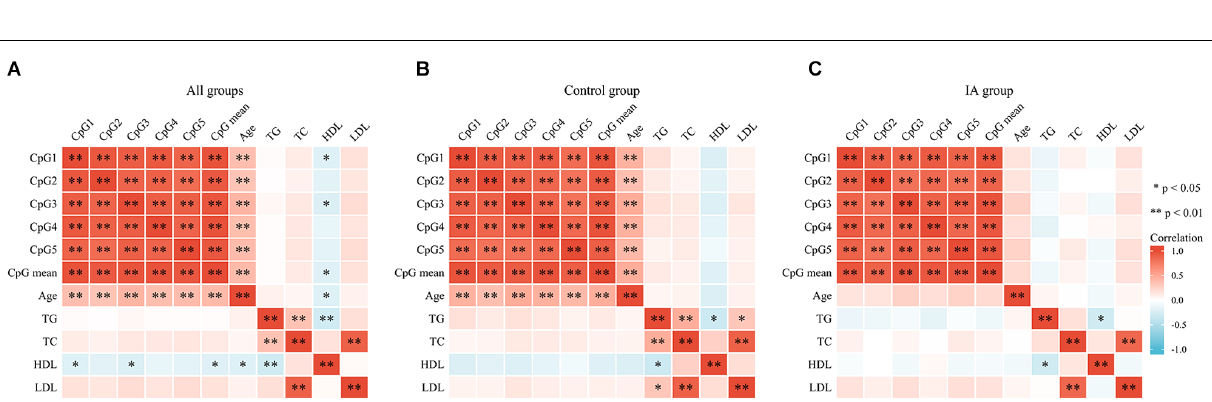
FIGURE 1 | The locations and analysis of the five CpGs in PNPLA6 gene. (A) The locations of the five CpGs in PNPLA6 gene. (B) Representative sequencing analysis of five methylation sites.